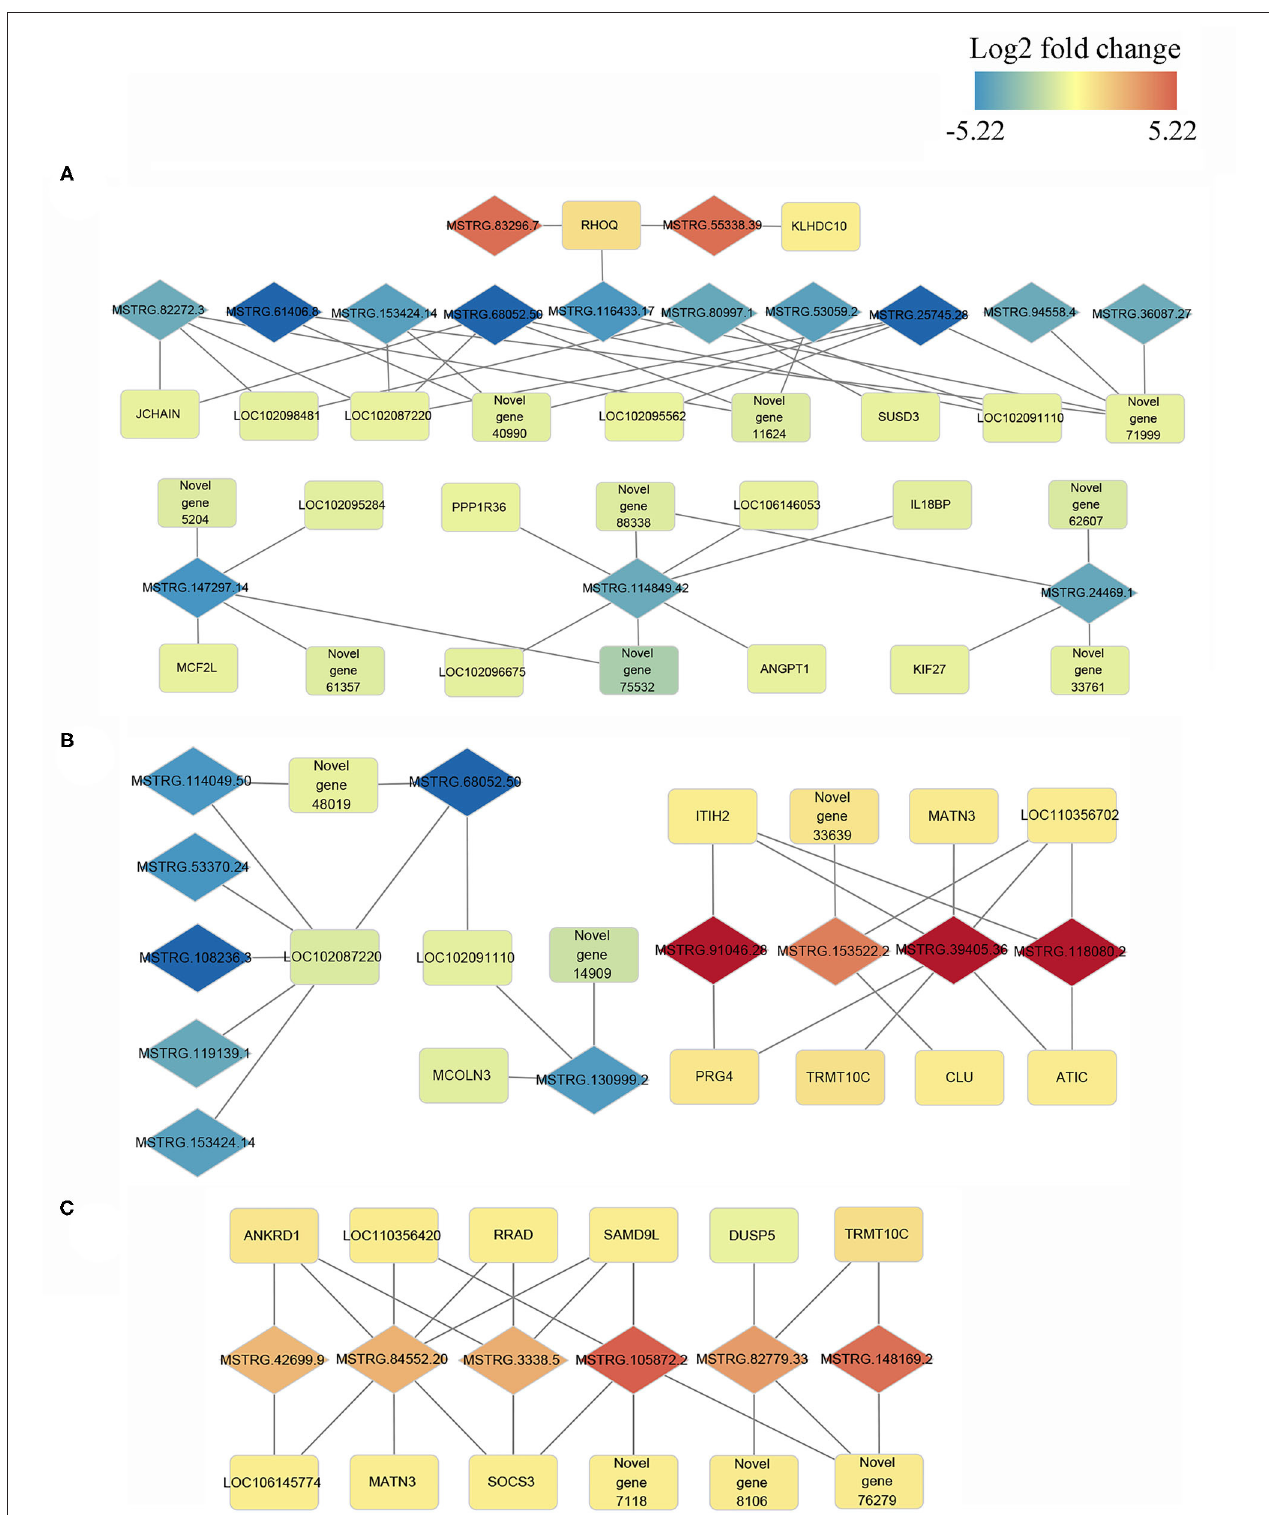
FIGURE 5 | Co-expression network of differentially expressed (DE) lncRNAs with their associated DE genes. Representatives of predicted interaction networks among DE lncRNAs and DE genes within control vs. tolerant birds’ contrast (A) , within control vs. susceptible birds’ contrast (B) and susceptible vs. tolerant birds’ contrast (C) . The gradual color of blue to red diamond and rectangle represent DE lncRNAs and DE genes, respectively. The black solid line denotes the connection of DE lncRNAs and DE genes.